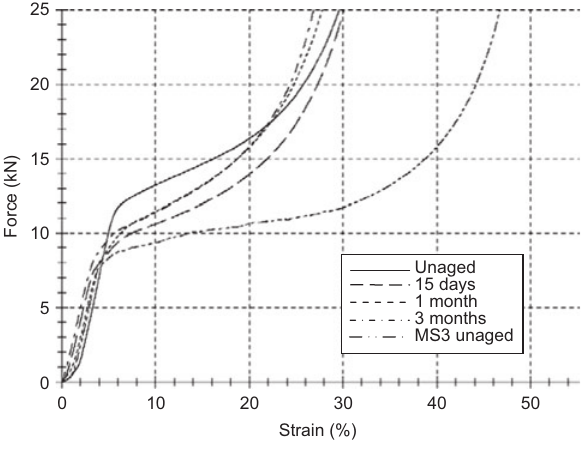
Figure 16 Compression curves of MS4 aged at 100 °